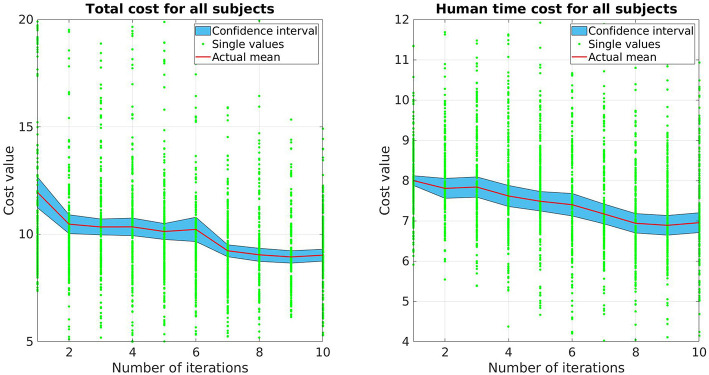
The mean and confidence interval of the total cost and human prediction time cost for all subjects.